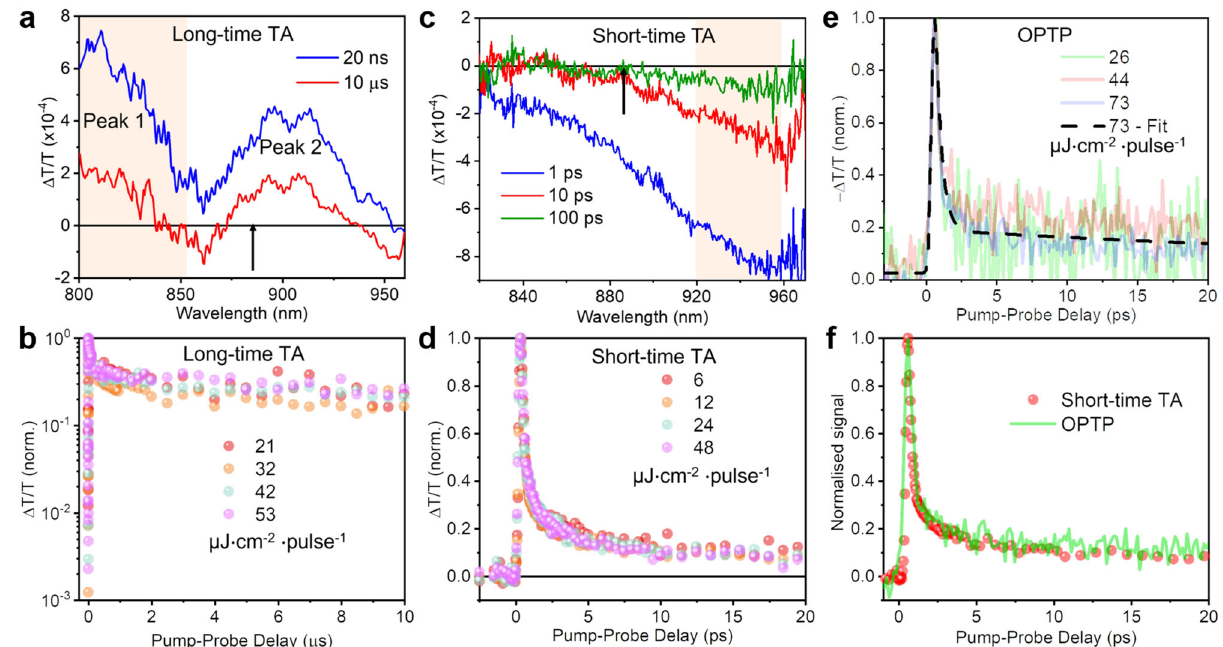
Fig. 3 | Charge-carrier kinetics in NaBiS 2 NC fi lms. a Long-time transient absorption (TA) spectrum of NaBiS 2 NC fi lms with 355nm wavelength pump exci- tationsandshownforpump-probedelaysof20ns(blue)and10 μ s(red),alongwith b its normalised ground state bleach (GSB) signal kinetics at different pump fl u- ences:21(darkpink),32(orange),42(green)and53(lightpink) μ Jcm − 2 pulse − 1 .The GSB kinetics were acquired by averaging the signals from 800 to 860nm (peak 1, shaded area in a ) and normalised to the maximum 4 T = T values. c Short-time TA spectrum of NaBiS 2 NC fi lms with 400nm wavelength pump excitations at pump- probe delays of 1ps (blue), 10ps (red) and 100ps (green), along with d its nor- malisedphoto-inducedabsorption (PIA)signalkinetics atdifferentpump fl uences: 6 (dark pink), 12 (orange), 24 (green) and 48 (light pink) μ Jcm − 2 pulse − 1 . The PIA